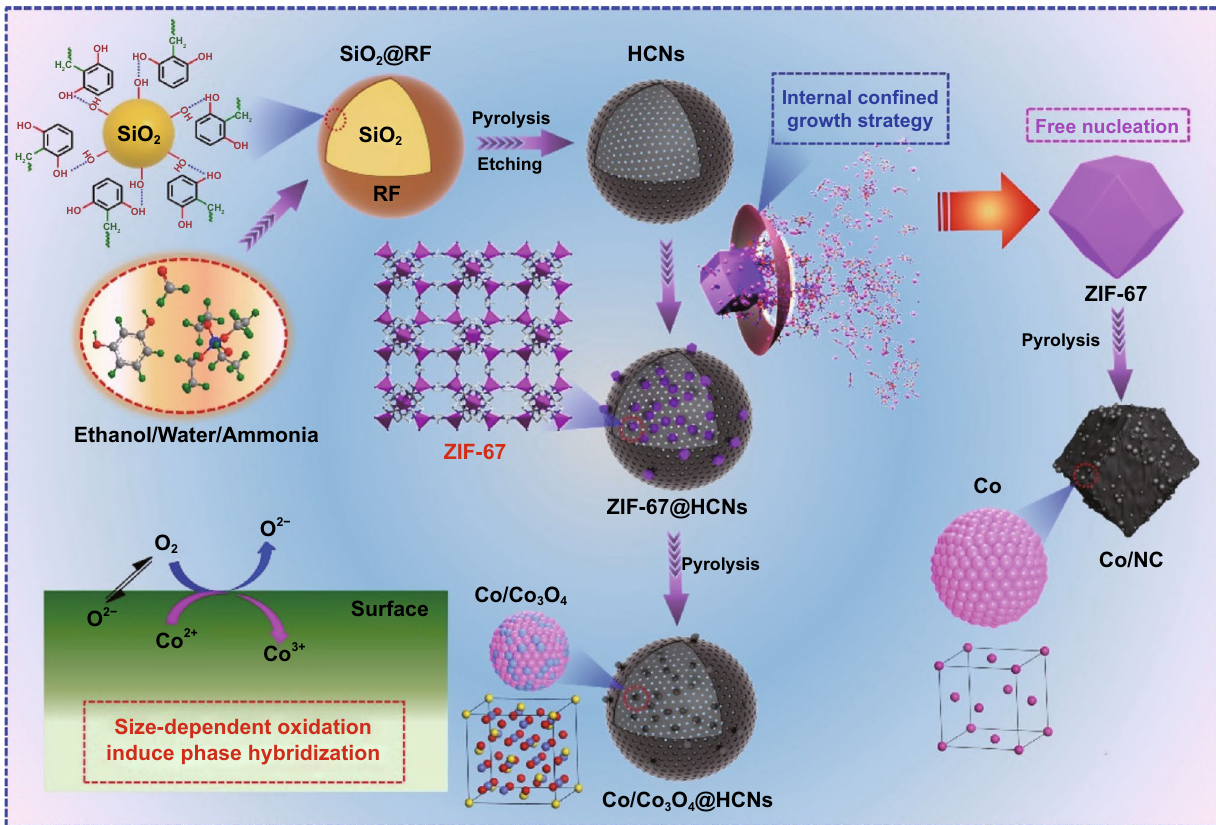
Fig. 1 The schematic illustration for the synthetic procedure of Co/Co 3 O 4